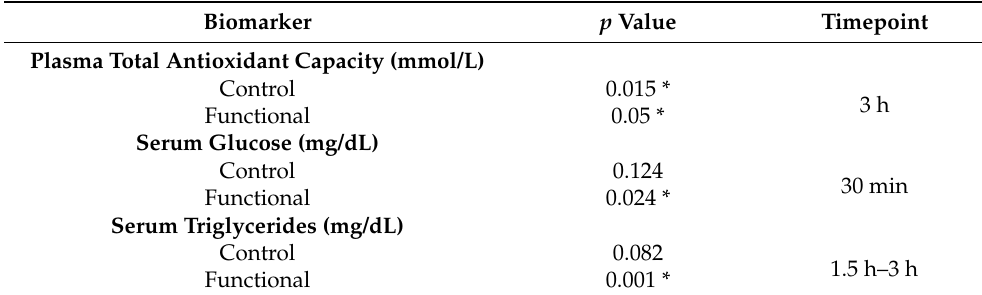
Table 5. Statistical significant effects of the Functional and Control meals on the biochemical parame- ters in specific